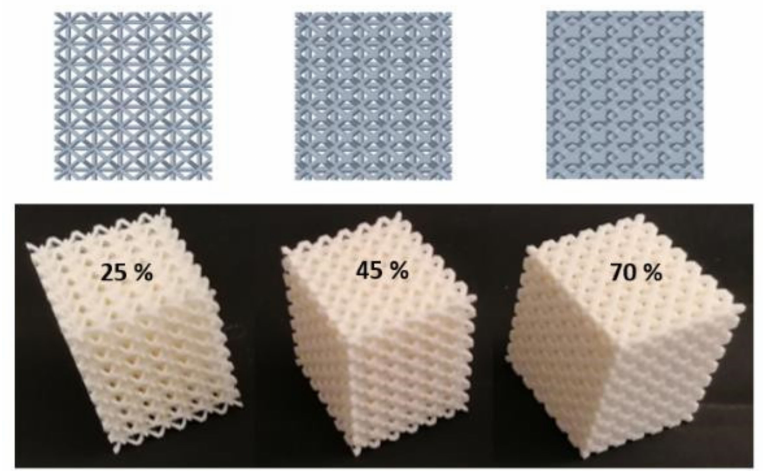
Figure 2. 3D models and produced samples with the cell size a = 5 mm and all three volume ratios V r = 25%, 45%, and 70%.